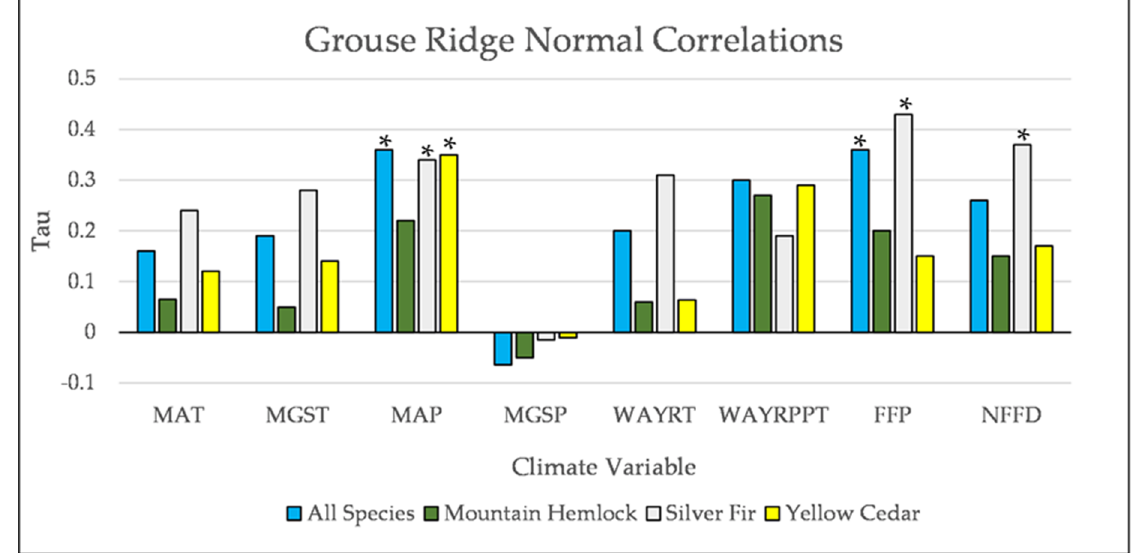
Figure A19. Normal Kendall’s correlations between establishment and annual and seasonal climate variables at Grouse Ridge. * = p -Value < 0.05. Mean Annual Temperature (MAT), Mean Growing Season Temperature (MGST), Mean Annual Precipitation (MAP), Mean Growing Season Precipitation (MGSP), Mean Water Year Temperature (MWYT), Mean Water Year Precipitation (MWYP), Frost Free Period (FFP), and Number of Frost Free Days (NFFD).